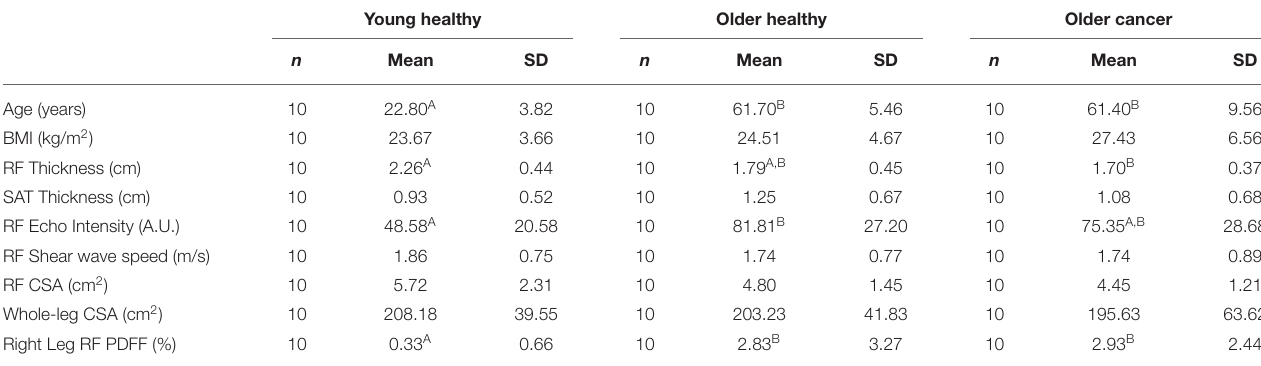
TABLE 1 | Descriptive statistics of each group. Young healthy Older